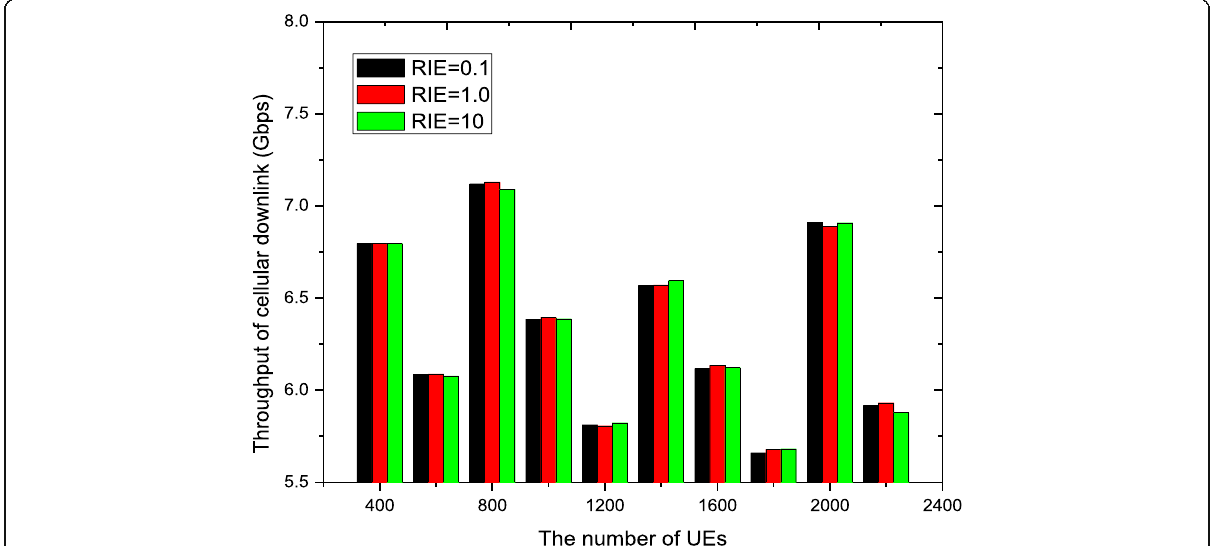
Fig. 13 Throughput for the DTO-MROD scheme under the different typical values for RIE